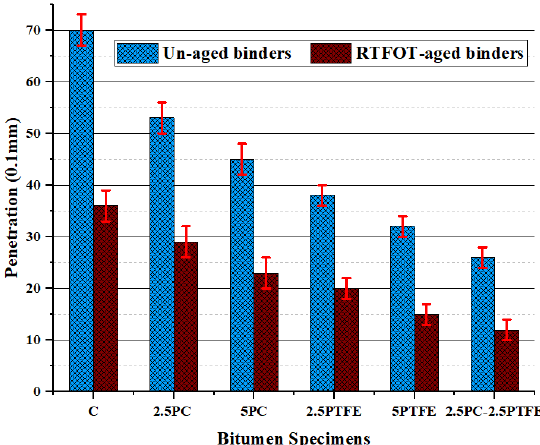
Figure 1. Penetration test values of binder before and after aging.